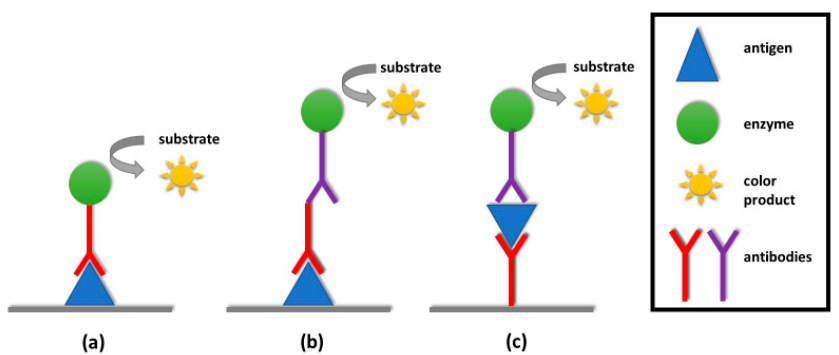
Figure 4. The scheme of ELISA: ( a ) direct assay; ( b ) indirect assay using enzyme modified Ab that selectively binds to a certain part of primary Ab; ( c ) indirect assay based on interaction of secondary antibody modified by enzyme with another binding site at the antigen. Adopted from [41].